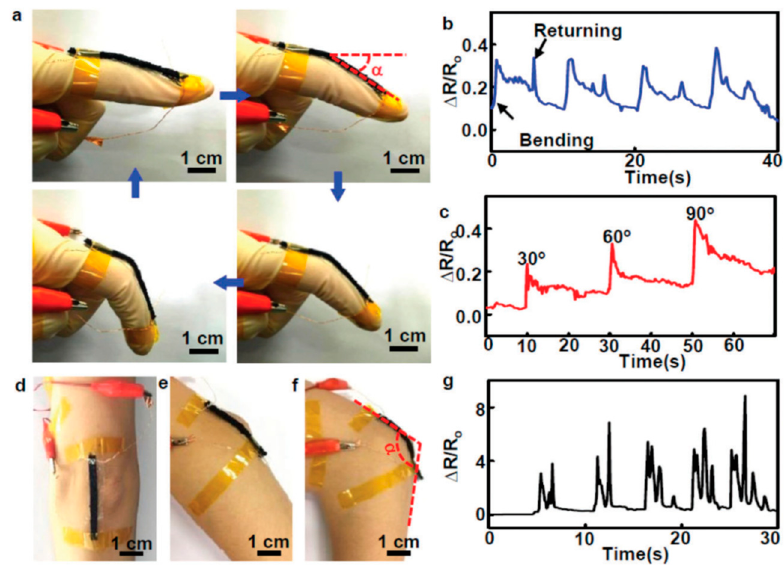
Figure 14. Detection of large-strain human motions with the strain sensor attached to the human finger and elbow joints. ( a ) Photographs showing the bending test of the finger; ( b ) the corresponding relative resistance change of the sensor in response to the finger bending; ( c ) the corresponding relative resistance change of the sensor in response to the different finger-bending angles; ( d – f ) photographs showing the bending test of the elbow; ( g ) the corresponding relative resistance change of the sensor in response to the elbow bending [137] (reproduced with permission).